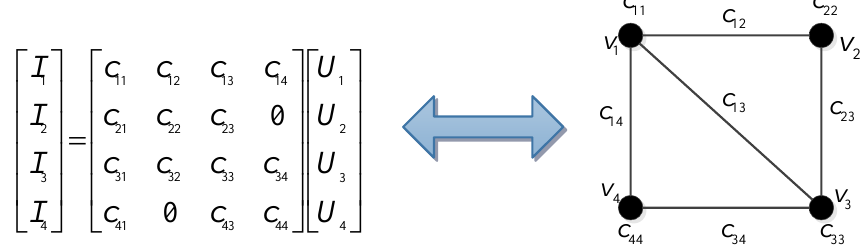
Figure 2. The relation between coefficient matrix and undirected graph.